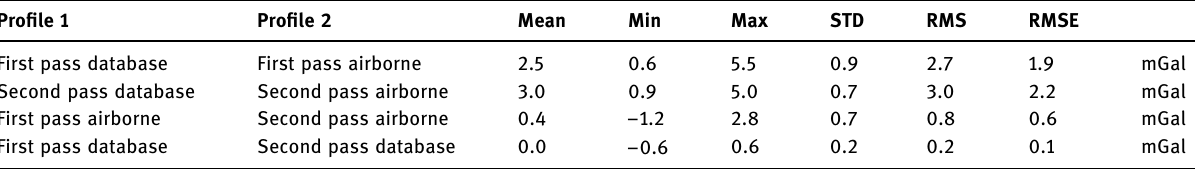
Table 2: Statistical variables derived from di ff erences between gravity pro fi les ( pro fi le 1 minus pro fi le 2 ) Pro fi le